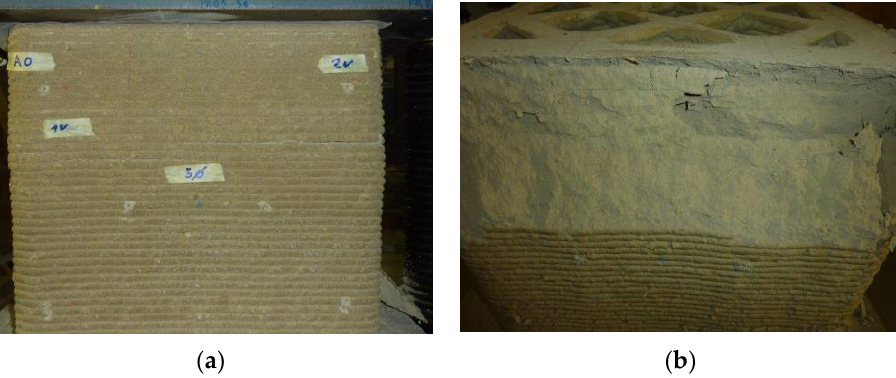
Figure 10. Failure mechanisms on the two short sides: ( a ) side located to the left of the operator, extending between edge 1 (left) and edge 2 (right); ( b ) side located to the right of the operator, extending between edge 3 (left) and edge 4 (right).